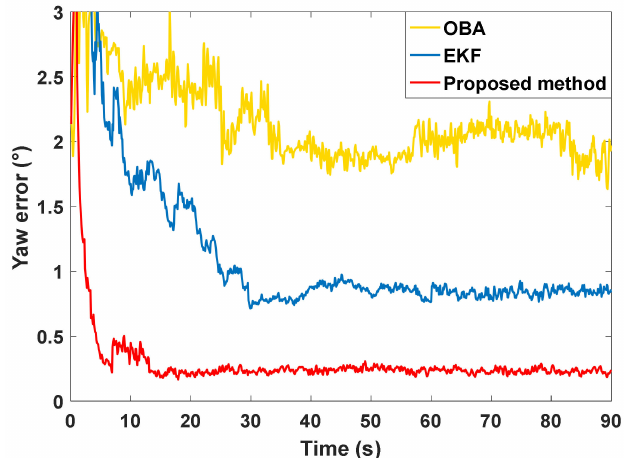
Figure 18. Yaw angle alignment error results of three different IFA